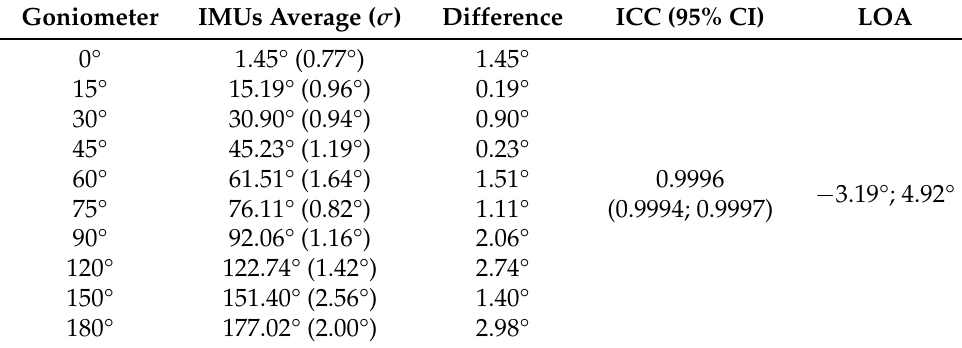
Figure 4. Results of experimental measurement campaign in laboratory. Table 4. Main statistical results of the laboratory measurement